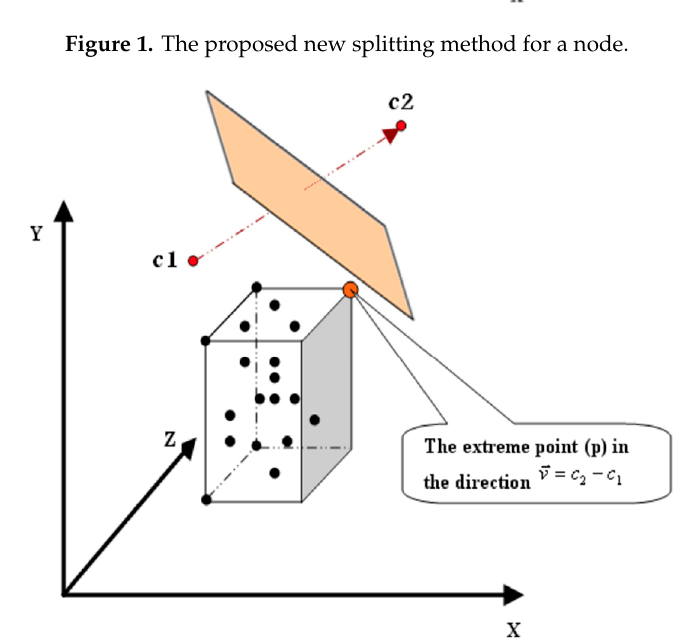
Figure 2. The mechanism of assigning a leaf to a cluster.